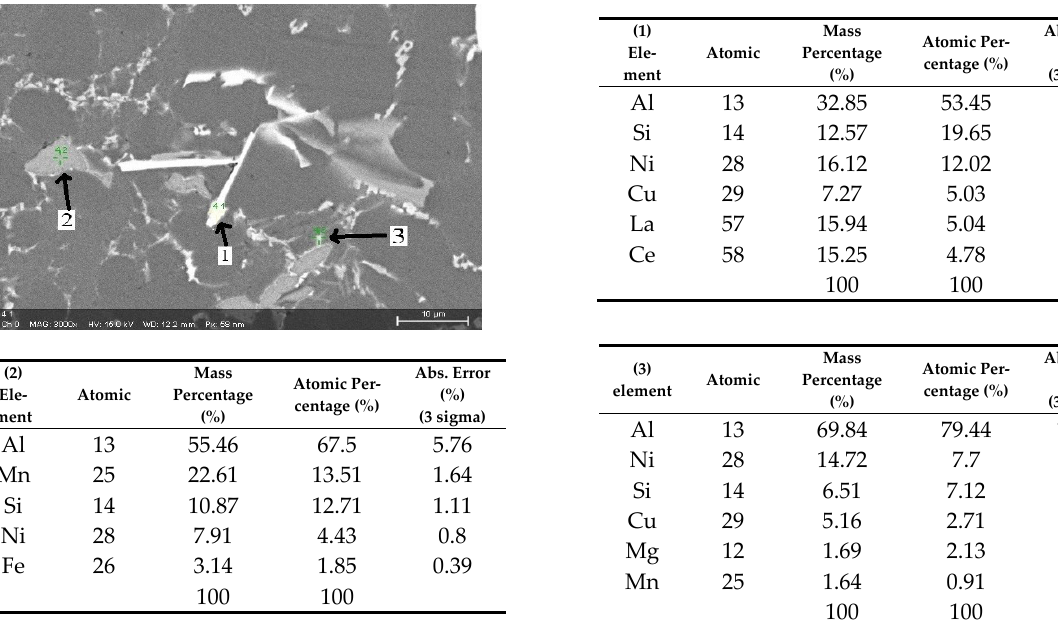
Figure 3. XRD result of the 4 alloys where the lines indicated are ( a ) 0% (Ce + La), ( b ) 1% (Ce + La), ( c ) 2% (Ce + La) and, ( d ) 4% (Ce + La).